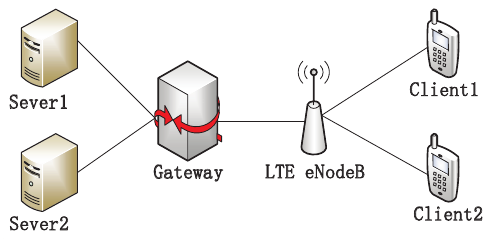
Figure 5. Simulation